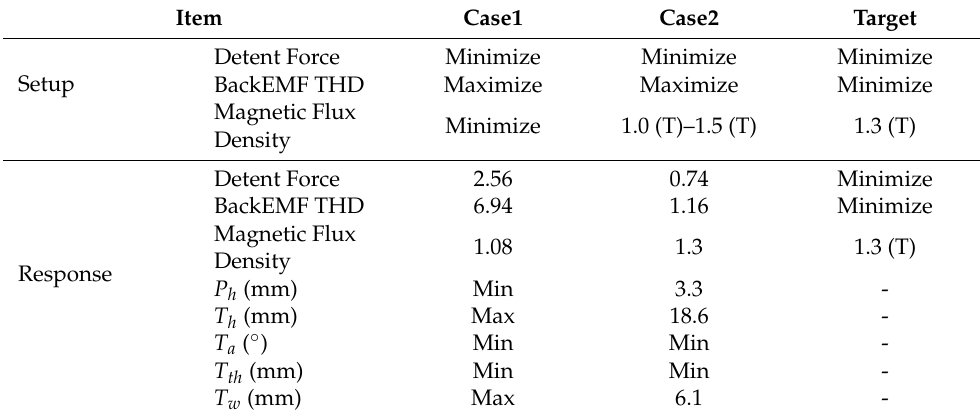
Figure 11. Response surface of an interaction term. ( a ) Detent force ( b ) Magnetic flux density ( c ) Back EMF THD. For the optimization of each objective function, a multi-objective optimization-based RSM was adopted. As shown in Table 8, the objective functions were optimized by varying the target values for each case. Table 8. Control factors and targets for each cases.